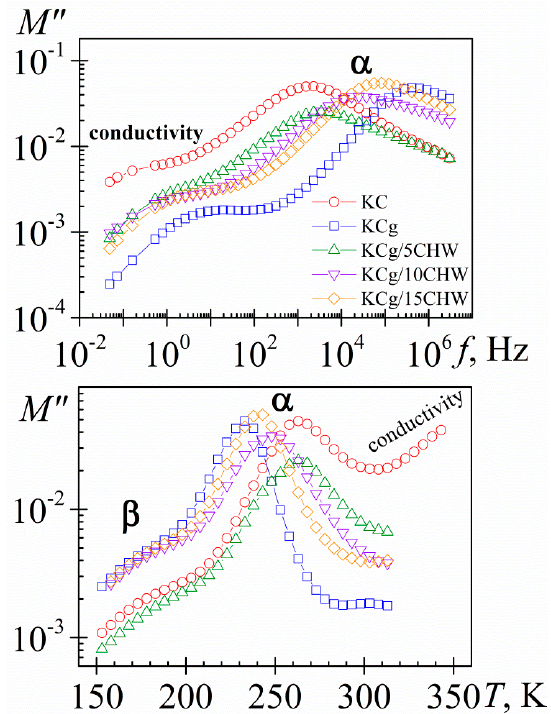
Figure 3. Frequency ( a ) and temperature ( b ) dependence of the loss modulus ( M” ) at 293 K and 10 2 Hz, respectively. KC (circle), KCg (square) and KCg / x CHW nanocomposites with x = 5 (up triangle), 10 (down triangle) and 15 (diamond).